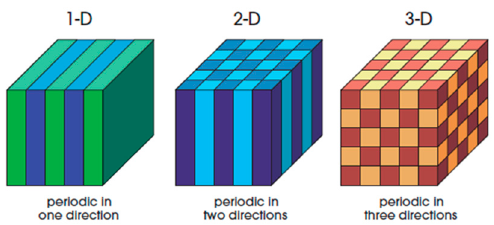
Figure 1. Simple illustrations of one-, two- and three-dimensional photonic crystals. The different colors represent different dielectric constants. The periodicity of the dielectric material along one or more axes is the defining feature of a photonic crystal.